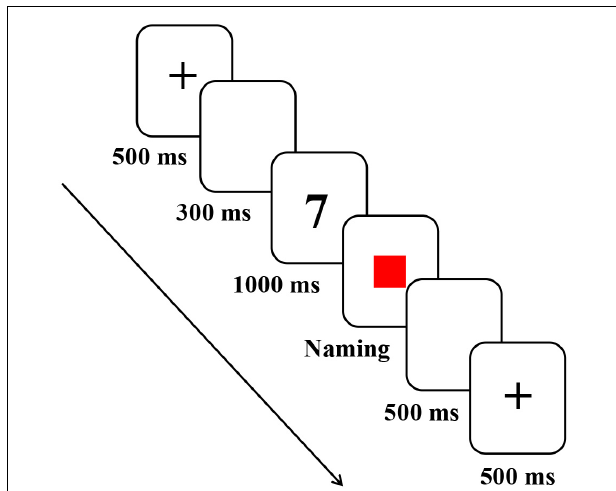
FIGURE 1 | Example of a trial